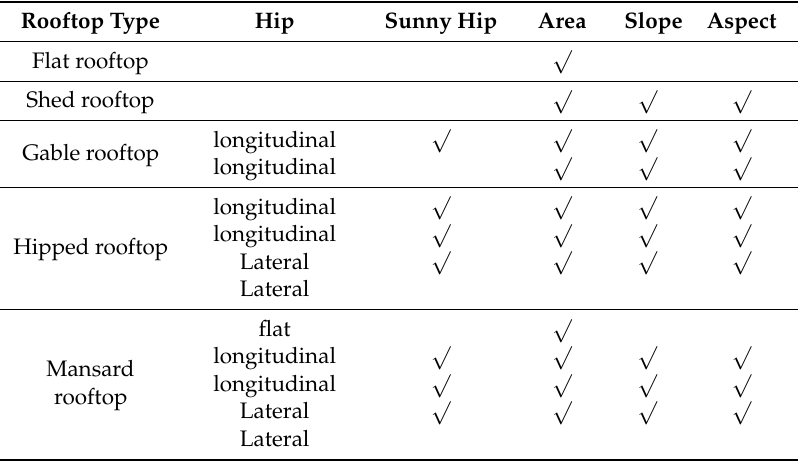
Table 3. Required rooftop feature parameters of each rooftop